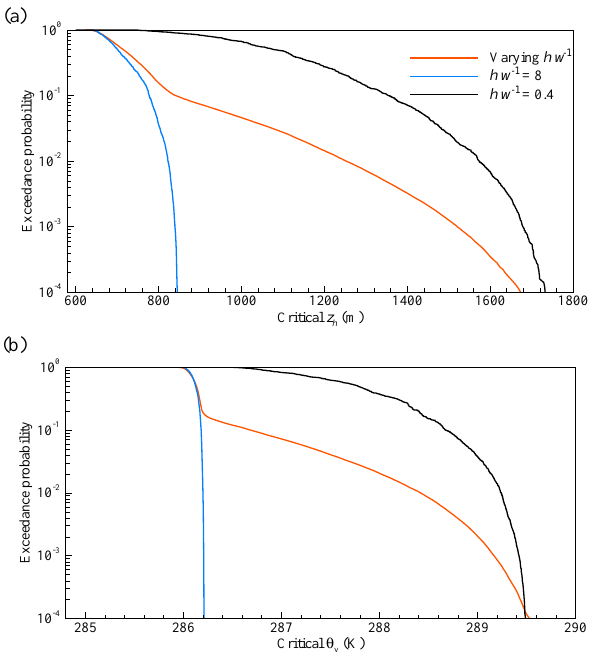
Figure 9. Illustration of the nonlinear effect of aspect ratio h/w on critical model responses of (a) z h and (b) θ v of the CBL